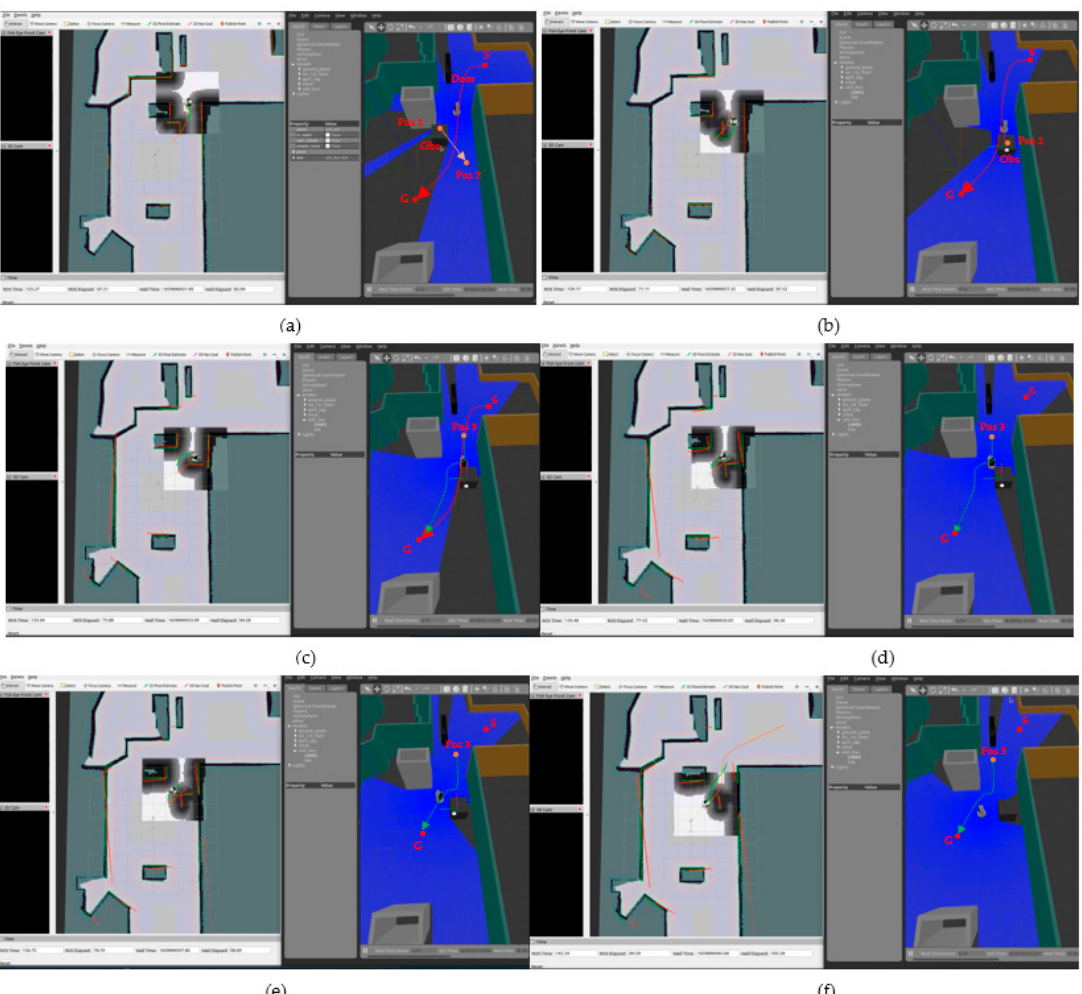
Figure 26. Optimized trajectory of mobile robot in the experimental moving obstacle scenario in ROS environment with the global path is dotted red lines and the re-path is dotted green lines: ( a ) Mobile robot moves from the start point S to goal point G, through the gate and avoid the obstacle Obs at Pos 1 (red dotted line); ( b ) After avoiding the obstacle Obs, mobile robot detect the moving obstacle at Pos 2; ( c ) The path is changed to ensure the moving obstacle Obs (green dotted line); ( d ) mobile robot moves successfully according to a new re-path; ( e ) mobile robot turn left to avoid the conner of the moving Obs; ( f ) mobile robot reaches to the goal point G with new re-path.